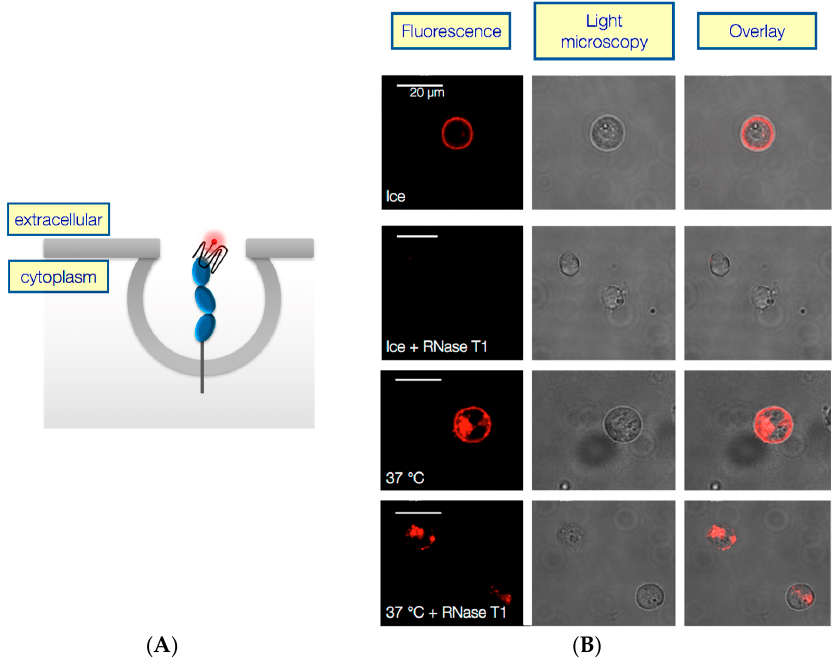
Figure 4. Fluorescently labeled aptamer AIR-3A is internalized by IL-6R presenting BAF/gp130/IL6R/TNF cells. ( A ) Schematic presentation of internalization process of G-quadruplex forming fluorescently labeled aptamer bound to the receptor IL-6R and ( B ) confocal laser scanning and light microscopy of IL-6R presenting cells after 30 min incubation with Atto645N-labeled AIR-3A at 37 °C and on ice (control, as internalization does not occur at 0 °C). Another control included an incubation with G specific ribonuclease (RNase) T1 which degraded surface bound RNA aptamers [4].